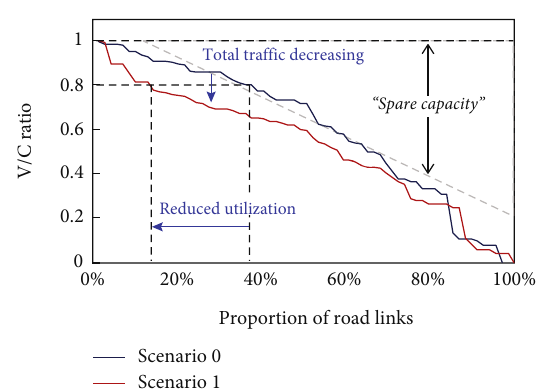
Figure 15: Change on road network utilization before and after adding new